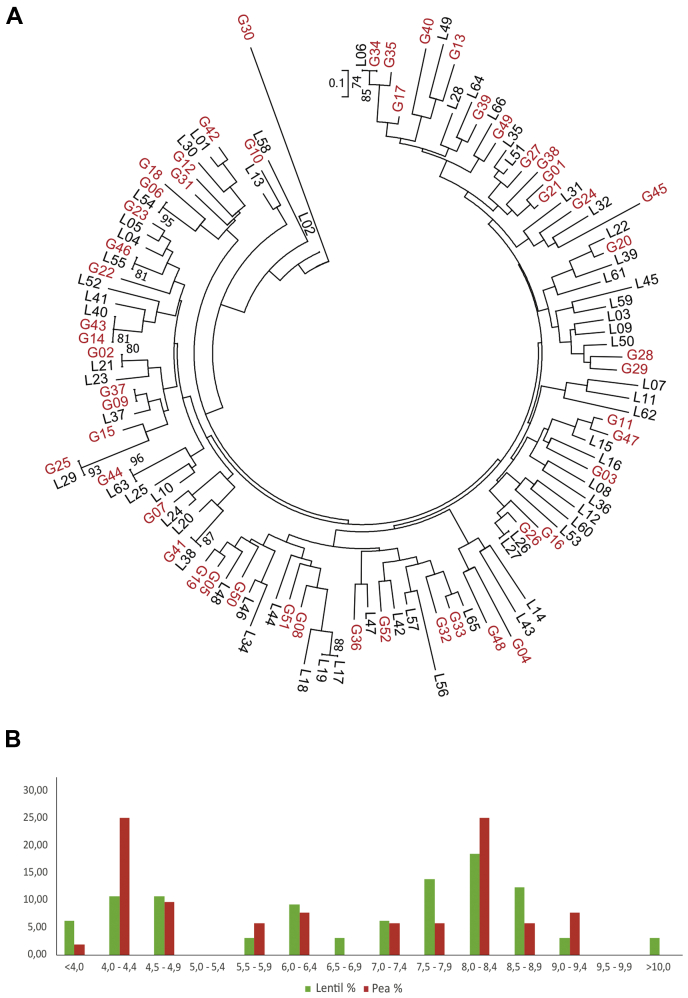
Analysis of NCR peptides identified in pea and lentil bacteroids. A, phylogenetic relationships of pea and lentil NCR peptides identified in this work. The evolutionary history was inferred using the Neighbor-Joining method. The analysis involved 117 amino acid sequences. Evolutionary analyses were conducted using MEGA7. B, distribution of the percentages of anionic (pI 4–6.5), neutral (6.5–7.5), and cationic (7.5–10) NCR peptides identified in bacteroids of Rlv UPM791 induced in pea (red bars) and lentil (green bars). NCR, nodule-specific cysteine-rich.